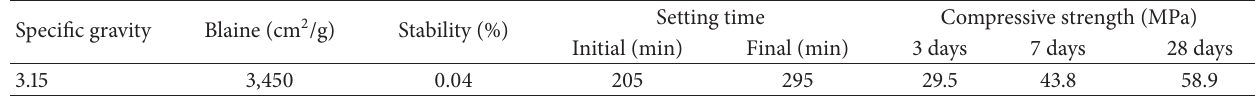
Table 1: Physical properties of cement.